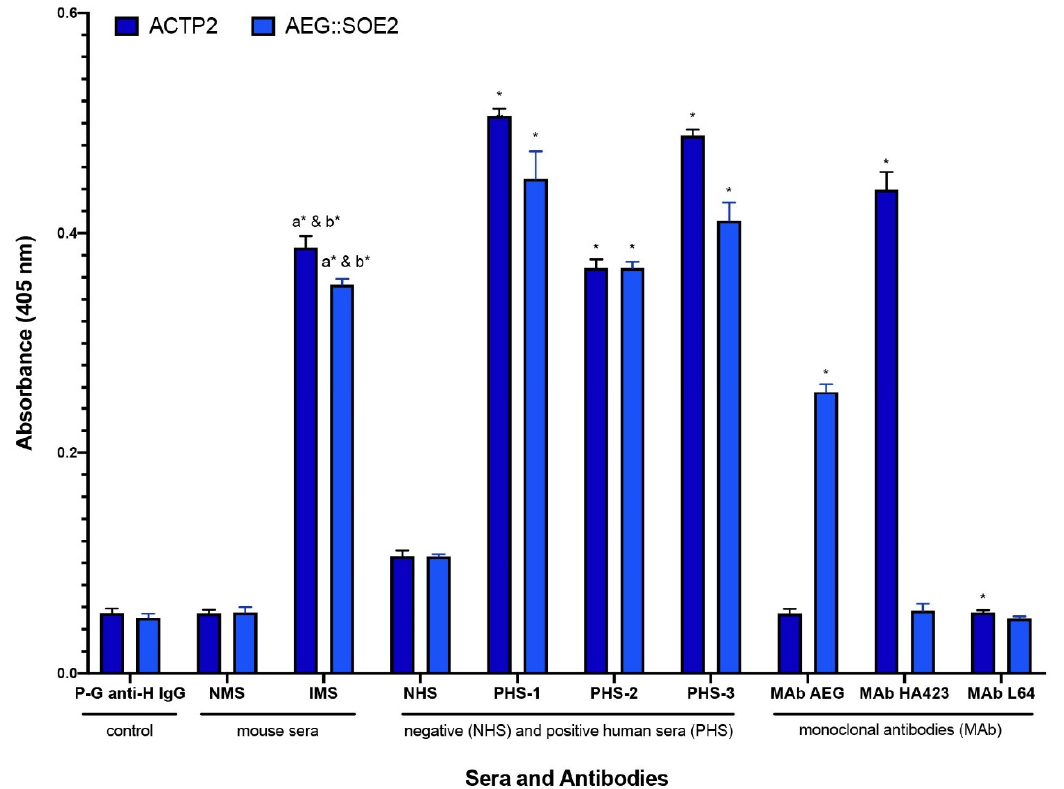
Figure 4. ELISA comparing negative (NHS) and positive women and men sera (PHS) and prebleed, normal mouse serum (NMS), and immunized mouse anti- T. vaginalis serum (IMS), for detection of IgG antibody to ACT-P2 (dark blue) and AEG::SOE2 (light blue). Bars represent means and standard deviations that were calculated for the average of all ELISA performed (n = 8). The secondary peroxidase-conjugated goat anti-human IgG (Fc fraction; labeled P-G anti-H IgG) is the secondary antibody used for ELISA for detecting human antibody and gave values equal to the use of 2% eBSA-PBS alone as a negative control. NMS sera gave values equivalent to secondary antibody alone. The pooled negative human sera (NHS) lacking reactivity to trichomonad proteins [24,25] represented five different women and five different men sera. The three pooled positive human sera (PHS) that detect trichomonad proteins represented either five women sera (number 1), five men sera (number 2), or five combined women and men sera (number 3). Independent t-tests were used to compare the mean absorbance levels for each target protein to its corresponding control. This included IMS vs. P-G anti-H IgG (a), IMS vs NMS (b), PHS-1 vs NHS, PHS-2 vs NHS, and PHS-3 vs NHS. The MAb cocktail mix is comprised of equal volumes (25 µ L) of hybridoma supernatants of the four MAbs